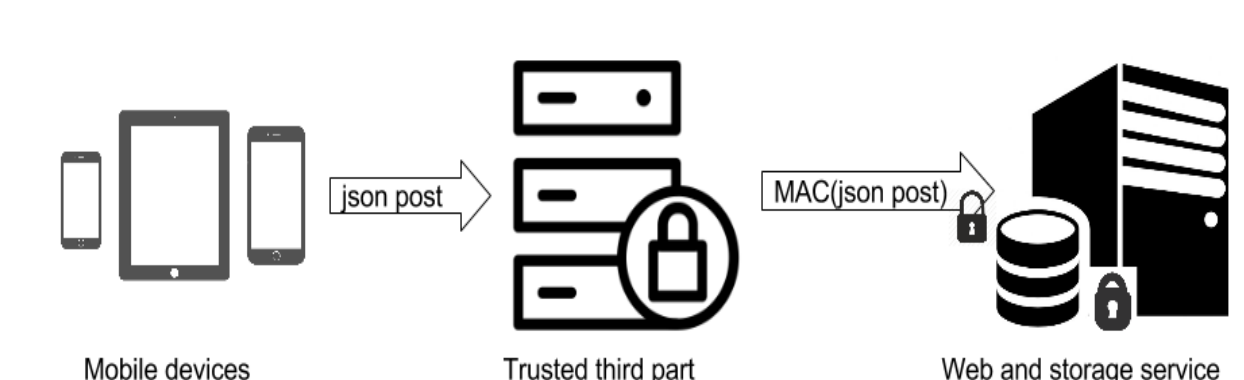
Figure 2. Data communication during